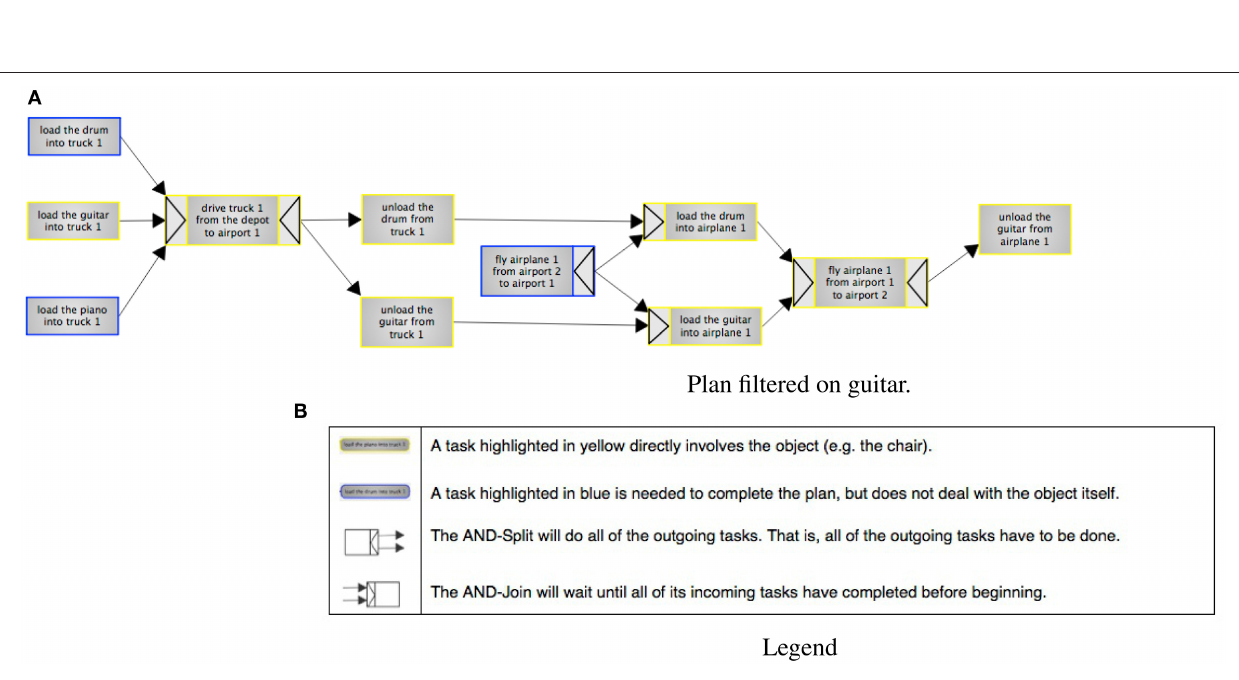
Frontiers in Psychology |